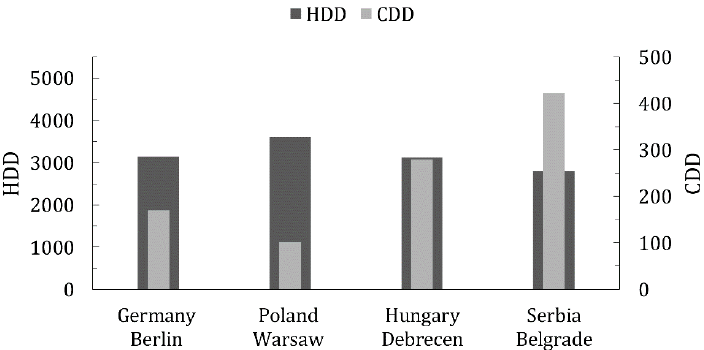
Figure 3. Used values for residential heating degree days (HDD) and cooling degree days (CDD) for observed locations. observed